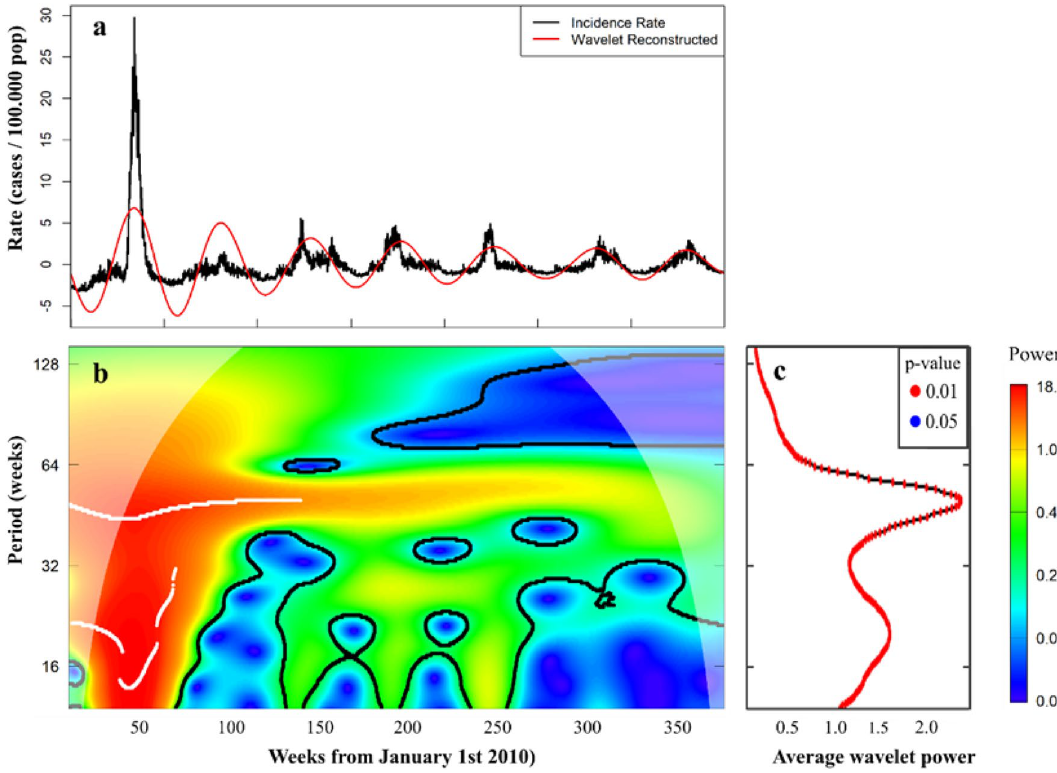
Figure 2. Detrended ILI incidence rate, wavelet reconstruction, local wavelet power spectrum and average power per period, Chile 2010–2016. ( a ) Detrended ILI incidence rate time series and wavelet reconstructed time series (red). Wavelet reconstruction using periods between 46 − 53 weeks, for Chile 2010–2016. ( b ) Local wavelet power spectrum of ILI rates for periods and time in weeks in Chile between 2010–2016. Significant power against white noise presented inside black contour. Ridge shown in white. A significant and high power was present through the complete time series for periods between 40 − 60. ( c ) Average power for periods, representing the average of local power from panel b with significance levels < 0.01 (red) and < 0.05 (blue) 24 .